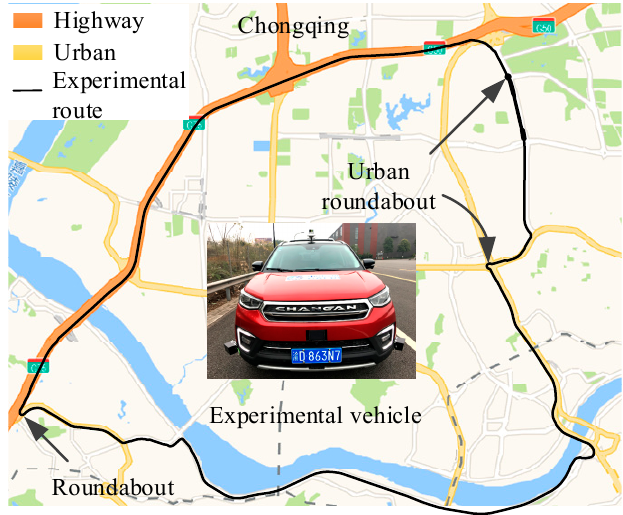
Figure 1. Vehicle and route for collection of driving data. It is found from Figure 2